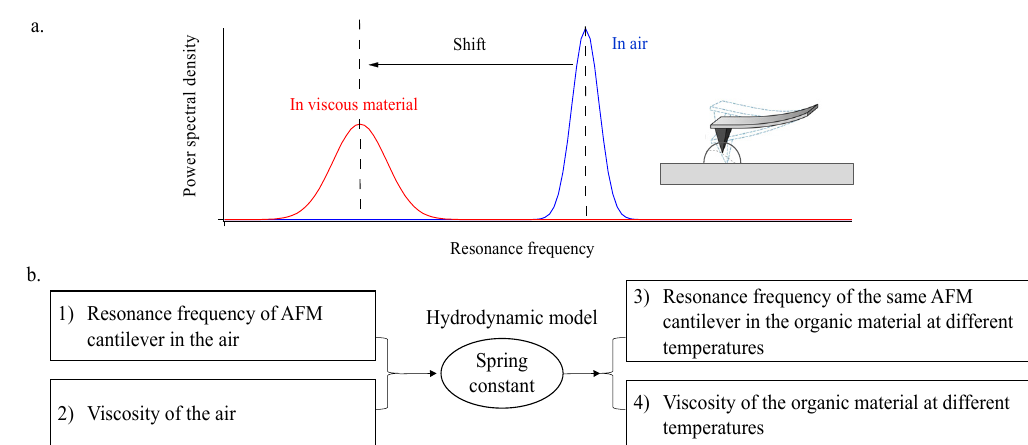
Figure 1. Schematic illustrating the technique of using AFM cantilever combined with hydrodynamic model in measuring the viscosity of organic materials at different temperatures. ( a ) Schematic illustrating the shift in resonance frequencies of AMF cantilever in air and in viscous materials; ( b ) Procedures in obtaining the viscosity of organic materials.